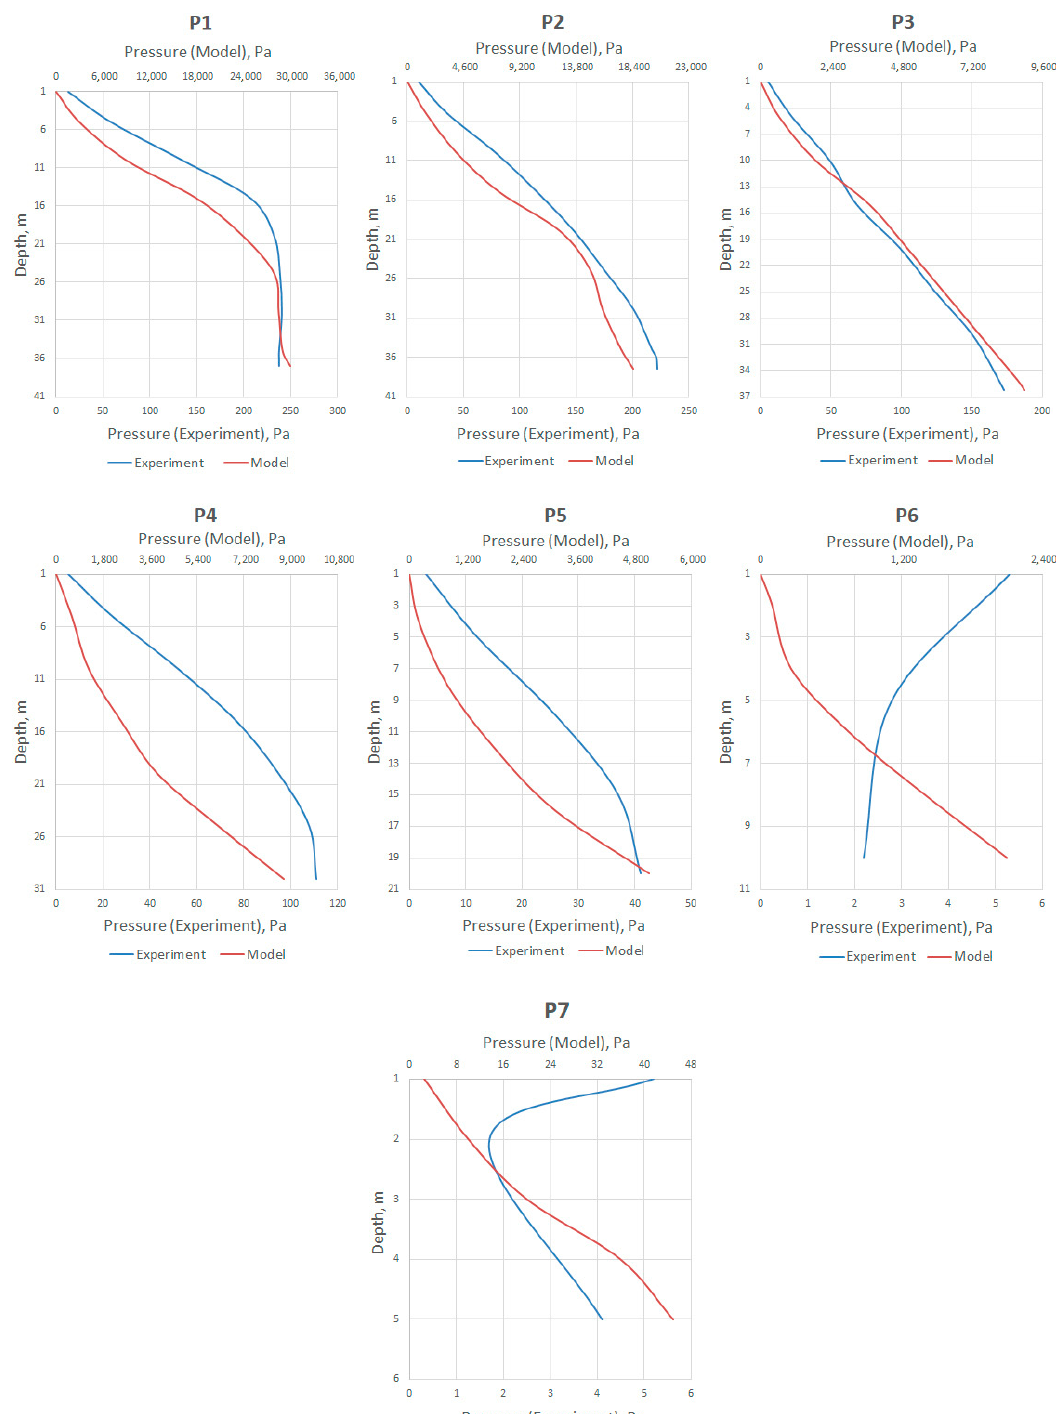
Figure 4. Vertical profiles of the distributions of hydroacoustic pressure at a frequency of 22 Hz at stations P1–P7.